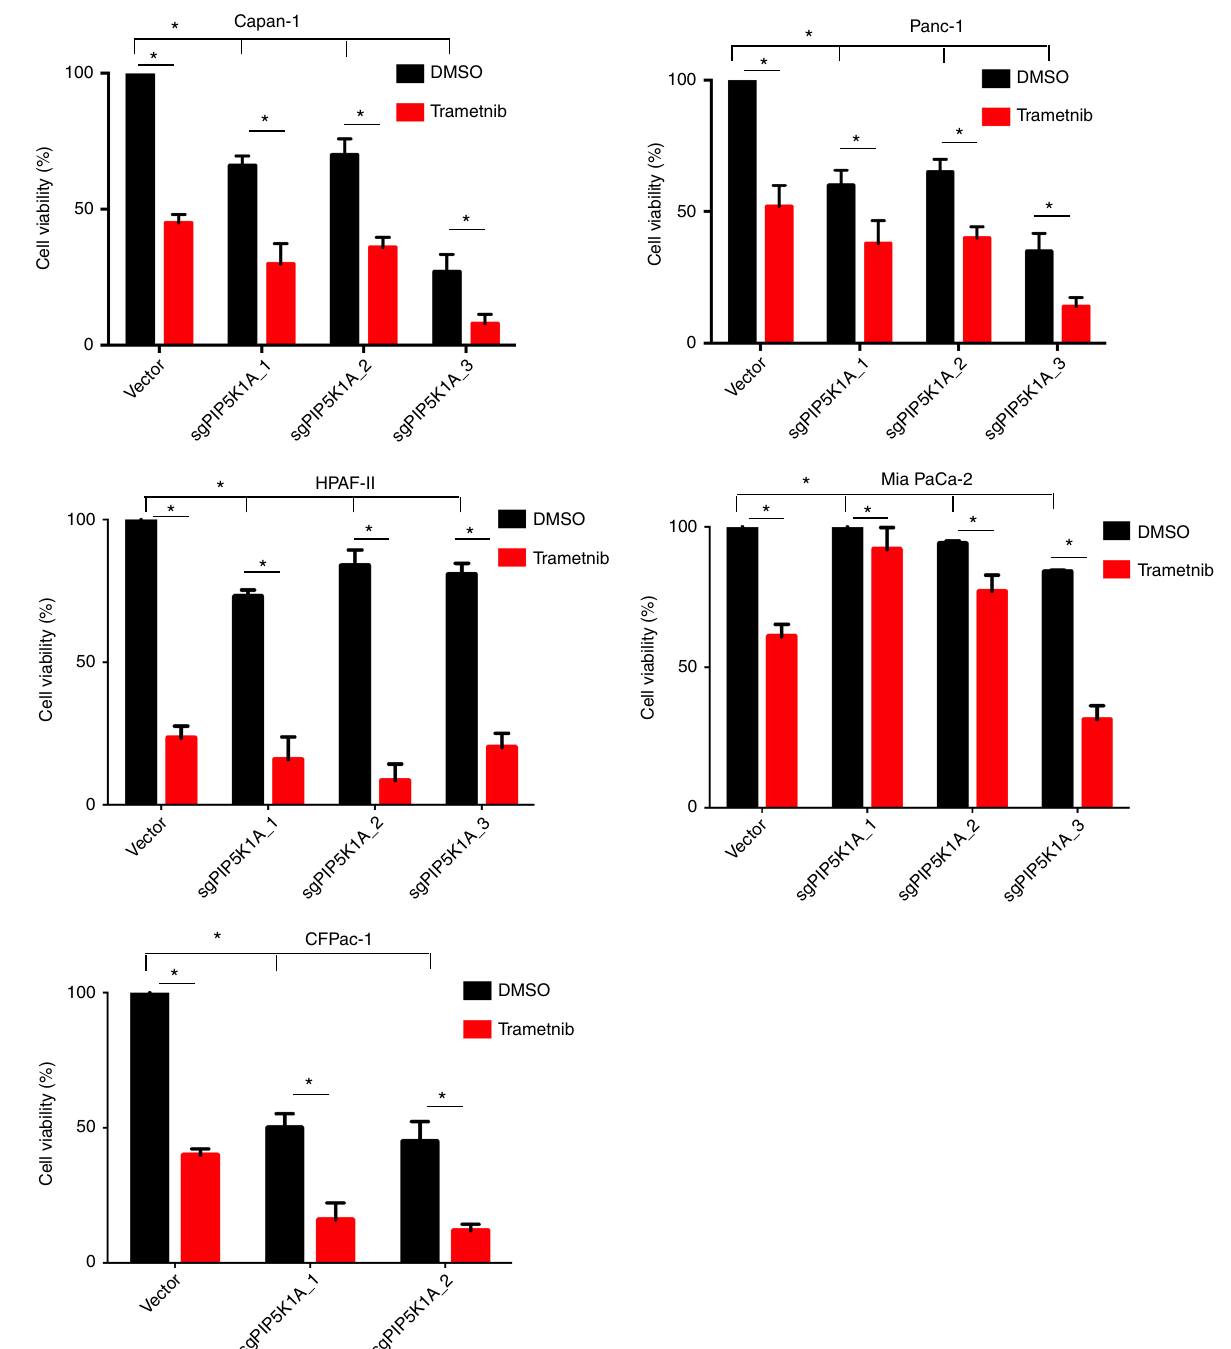
Fig. 6 PIP5K1A loss is additive with a MEK inhibitor in KRAS -mutant cancer cells. Percent cell viability (mean ± SD, triplicate samples, two experiments, normalized to vector control cells treated with DMSO) of the indicated KRAS -mutant human cancer cell lines stably infected with a lentiviral vector encoding Cas9 and no transgene (vector) or one of up to three independent sgRNA targeting PIP5K1A (sgPIP5K1A-1 to -3) after treatment with vehicle (DMSO) or 25 nM of trametinib for 72 h. * p = 0.05, two-way ANOVA